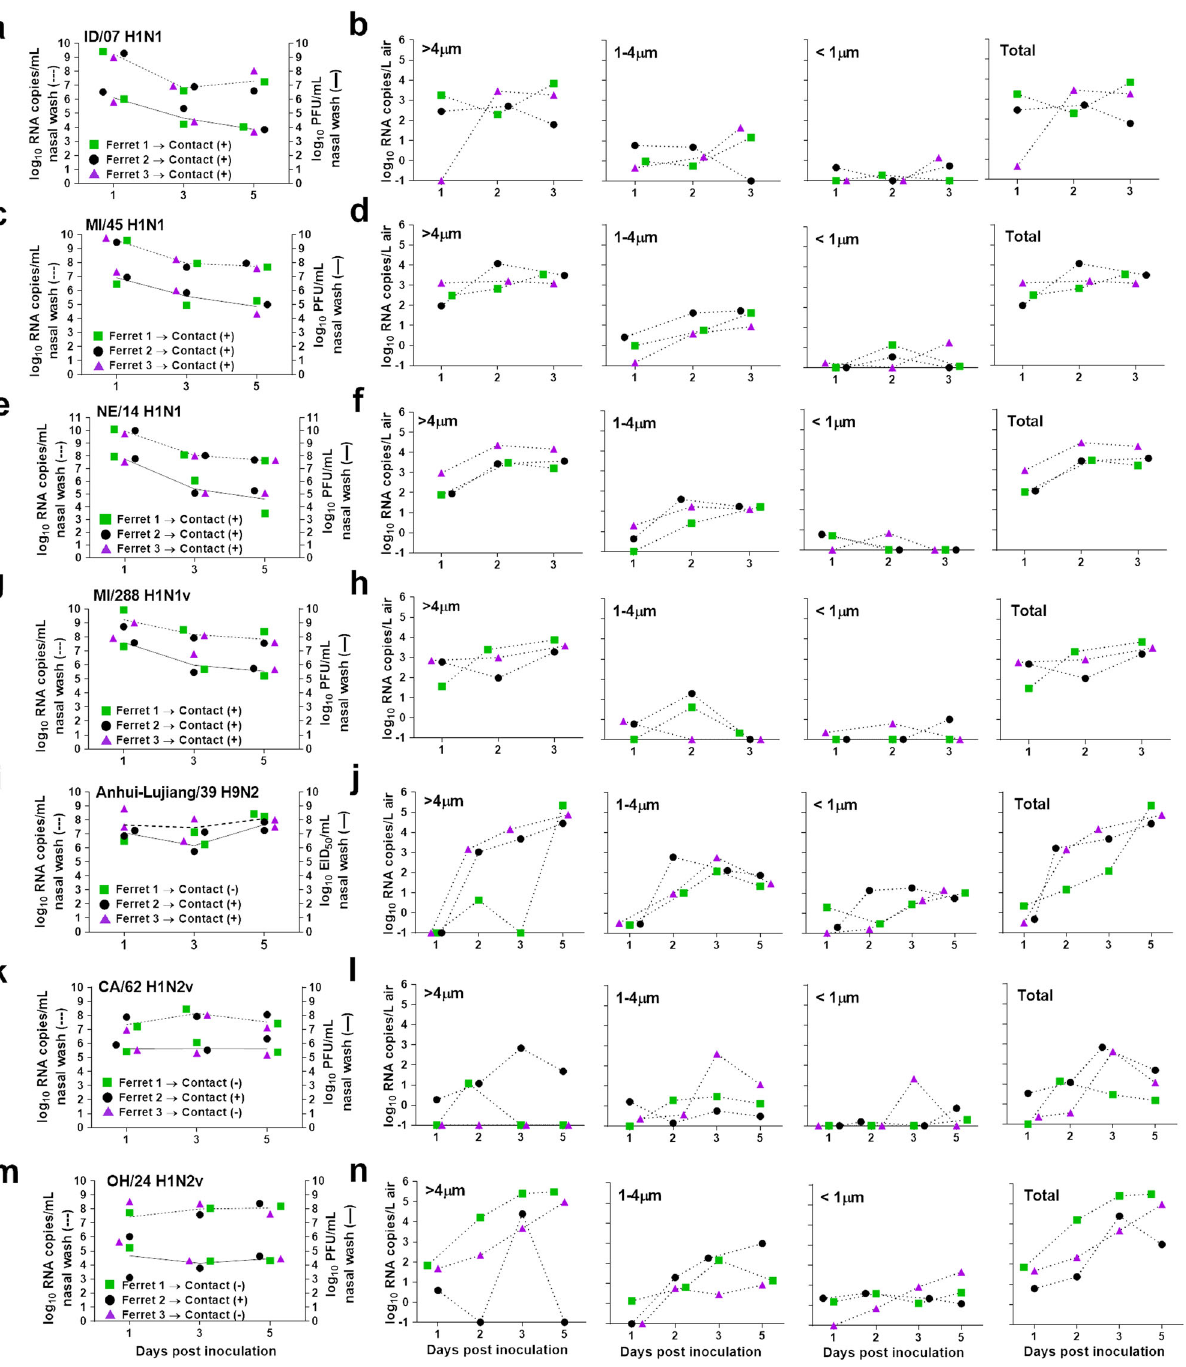
Fig. 2 In fl uenza A viral RNA measured in the air during ferret transmission experiments. Three ferrets per group were inoculated with A/Idaho/07/2018 A(H1N1)pdm09 a , A/Michigan/45/2015 A(H1N1)pdm09 c , A/Nebraska/14/2019 A(H1N1)pdm09 e , A/Michigan/288/2019 A(H1N1)v g , A/Anhui-Lujiang/ 39/2018 A(H9N2) i , A/California/62/2018 A(H1N2)v k , A/Ohio/24/2017 A(H1N2)v m . The following day a naïve ferret was placed in an adjacent cage allowing for air exchange via perforated cage walls to assess airborne transmission. Infectious virus in nasal wash samples was quanti fi ed using plaque assay or by egg titration (solid lines; data source listed in Table 1; limit of detection 1 log 10 PFU/ml or 1.5 log 10 EID 50 /ml), and viral RNA copies were quanti fi ed using real time qRT-PCR (dashed lines; data generated in this study; limit of detection 1 log 10 RNA copies/ml). Individual ferrets are shown as different symbols (ferret 1-green square, ferret 2-black circle, ferret 3-purple triangle). The plus sign indicates that infectious virus was detected in nasal wash samples collected from contact animals by day 5 post-contact; the negative sign indicates that transmission did not occur as con fi rmed by lack of the virus in nasal wash samples and by lack of seroconversion (Transmission data source listed in Table 1). Air samples were collected from each ferret cage for 2h on indicated days using a two- stage cyclone sampler which fractioned particles by size: >4 µ m, 1 – 4 µ m, <1 µ m (perforated cage side wall was blocked during air sampling). Viral RNA in each sample was quanti fi ed using real timeqRT-PCR and the datafor each virus; A/Idaho/07/2018 A(H1N1)pdm09 b , A/Michigan/45/2015 A(H1N1)pdm09 d , A/ Nebraska/14/2019 A(H1N1)pdm09 f , A/Michigan/288/2019 A(H1N1)v h , A/Anhui-Lujiang/39/2018 A(H9N2) j , A/California/62/2018 A(H1N2)v l , A/ Ohio/24/2017 A(H1N2)v n , and individual ferrets is shown (limit of detection 0.1 RNA copy/L of air). COMMUNICATIONS BIOLOGY| (2023) 6:90 |https://doi.org/10.1038/s42003-023-04459-0|www.nature.com/commsbio